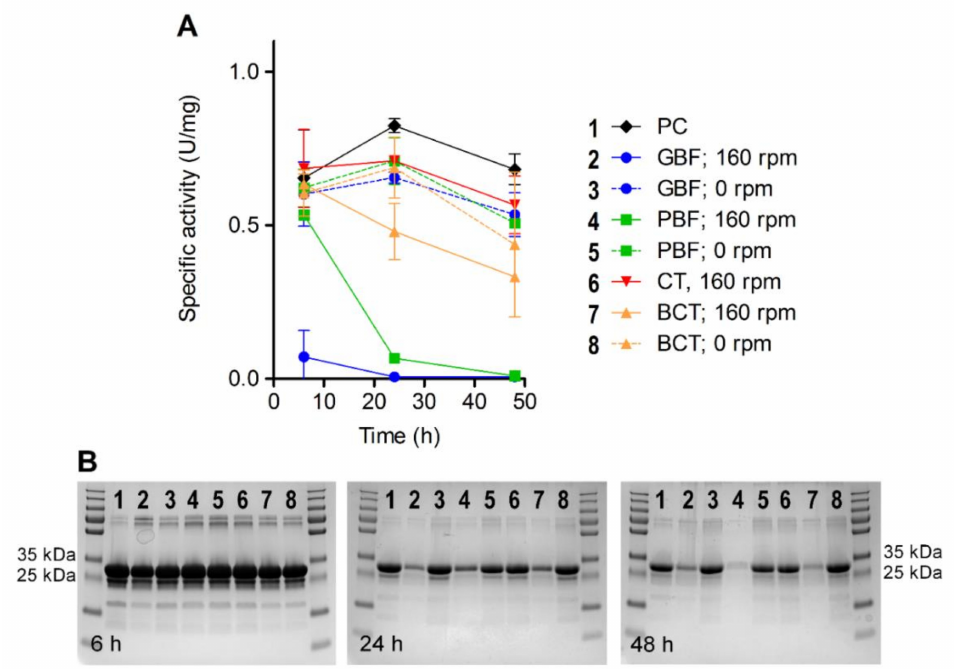
Figure 5. Measurements of HY-133’s specific activity ( A ) and stability ( B ) upon incubation under different in vitro conditions. Measurements were carried out after 6 h, 24 h, and 48 h of incuba- tion. As a positive control, HY-133 was freshly applied at each measurement. PC, positive control (fresh HY-133); GBF, glass baffled flask; PBF, plastic baffled flask; CT, centrifuge tube; BCT, baffled centrifuge